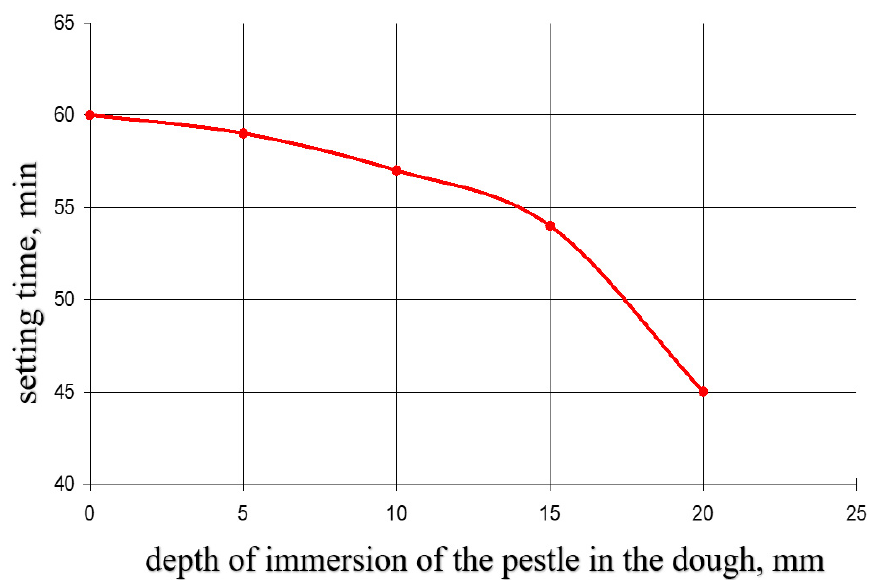
Figure 4. Dependence of setting time on the plasticity of the dough.